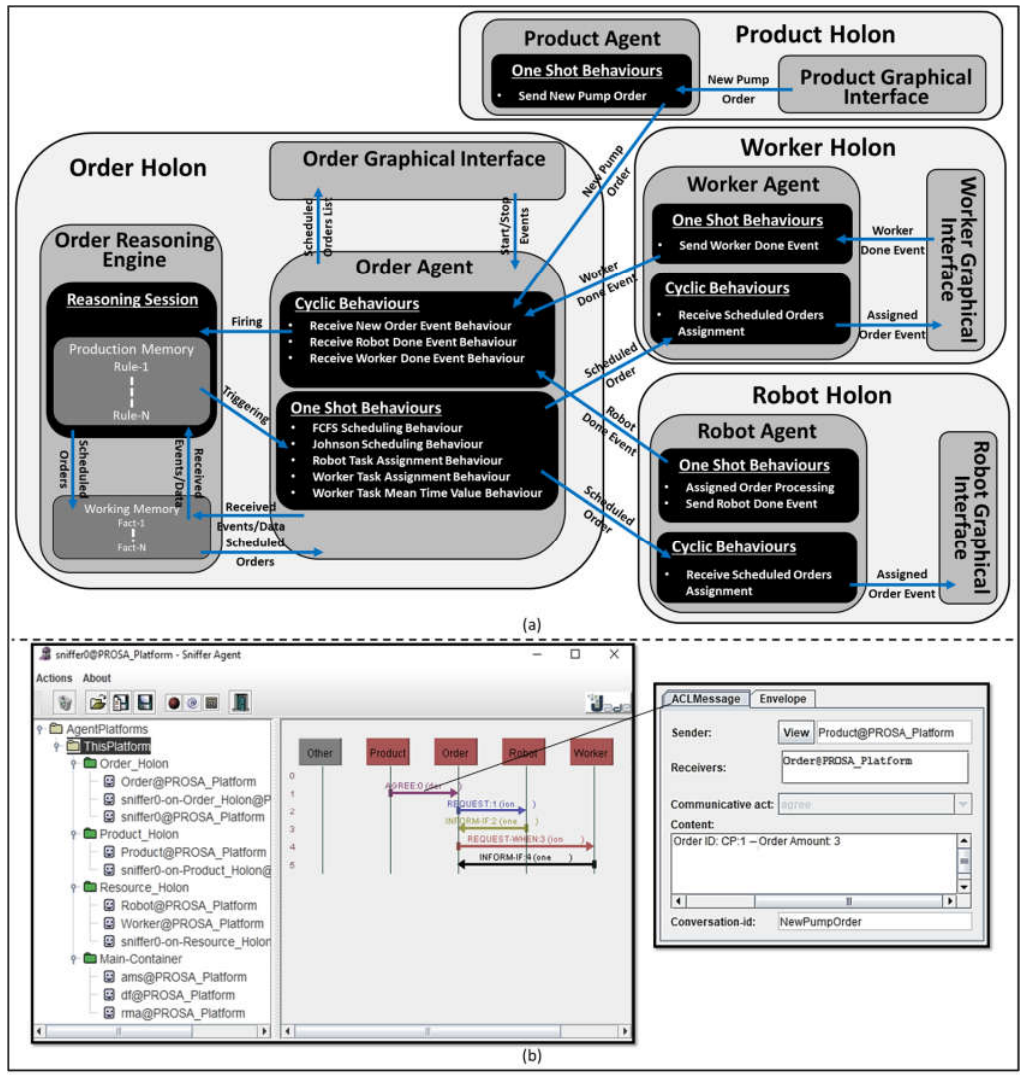
Figure 7. ( a ) Case-study holons interaction and behaviors; ( b ) Case-study communication